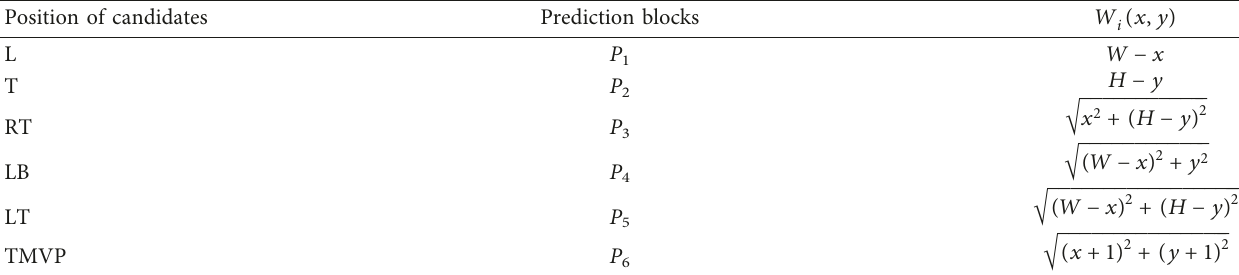
Table 1: Definition of weighted coefficients for each candidate.